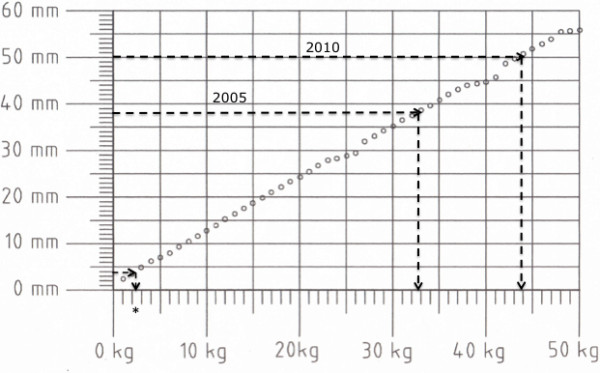
Force-depth relationship of the manikin used in this study. Dashed arrows indicate the corresponding force for the minimal recommended chest compression depth of 38 mm (2005 Guidelines), and 50 mm (2010 Guidelines), respectively. The star indicates the threshold used by Fried et al. to define leaning on the patient's chest [20].